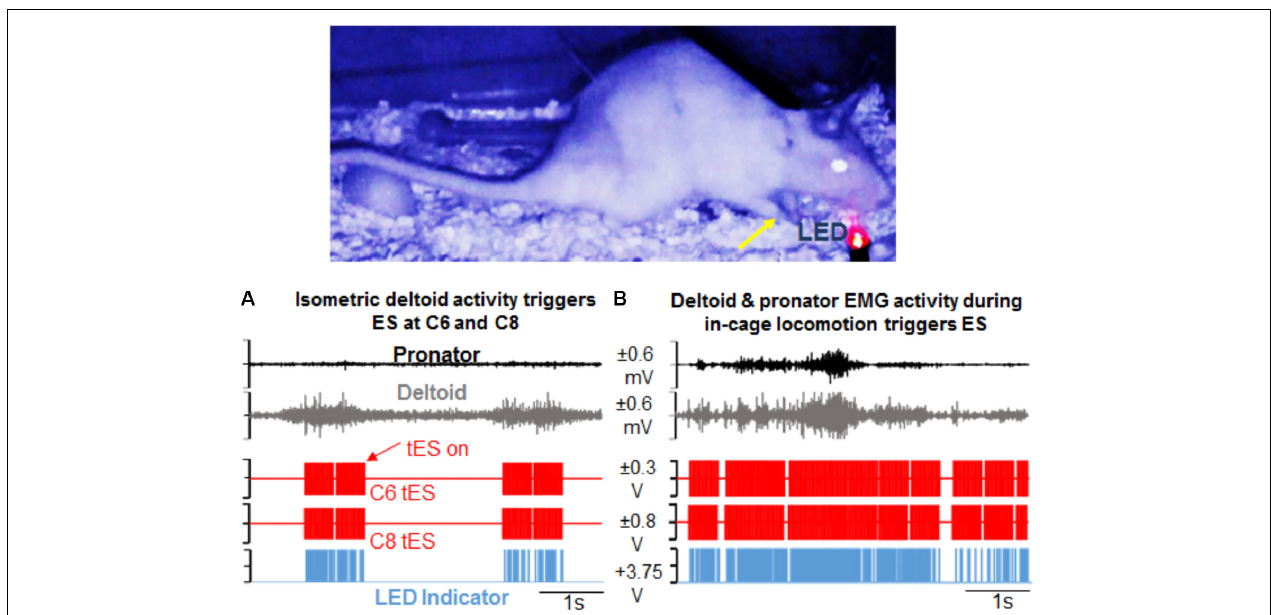
FIGURE 6 | Demonstration of activity-dependent ES of the cervical cord segments triggered by pre-defined EMG signal thresholds (tES) during overnight training in the rat’s home cage. (A) Standstill image that corresponds to a frame in the video is synced with precise time of an ongoing forelimb EMG activity. The EMG signal corresponds to forelimb weight support (yellow arrow) in the rat’s home cage at night. Note that activity in the deltoid muscle alone triggers ES of the C6 and C8 spinal cord segments (red pulses). Stimulation occurs in response to muscle activity measured via EMG signal only at a defined threshold (tES on). With no muscle activity present, tES shuts off automatically. LED on the video blinks red when the EMG signal crosses a threshold to trigger ES and is also recorded as a pulse (blue) in the data collection software. (B) Shown is a similar snapshot of a video frame that corresponds to deltoid and pronator muscle EMG activity during a forelimb locomotor task in the cage. The deltoid muscle threshold keeps the ES switched on for a longer